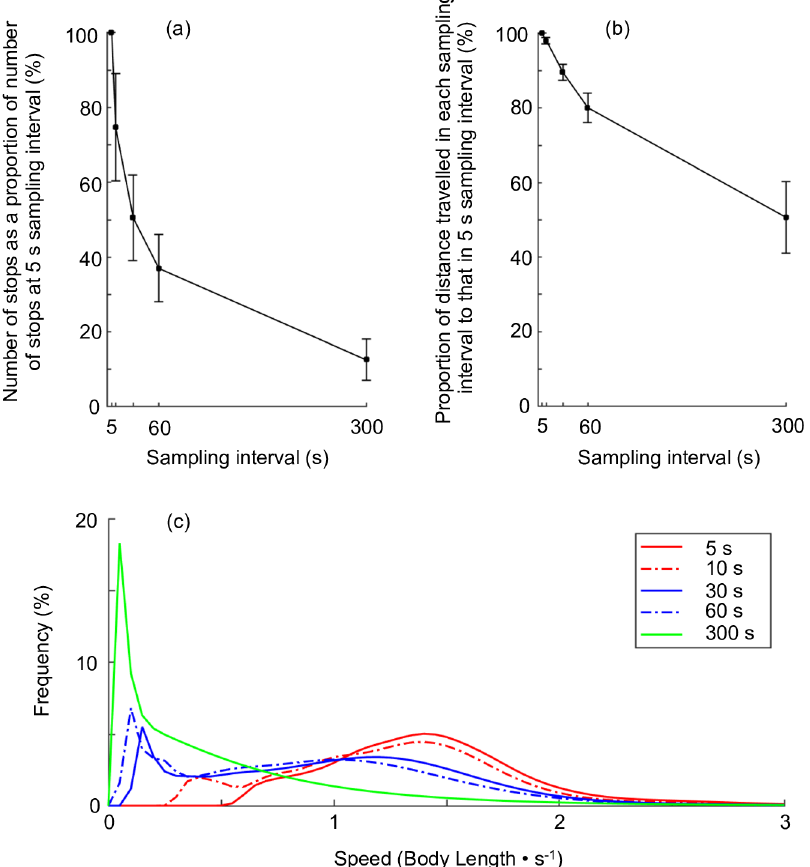
Fig 7. Comparison of stop numbers, distance travelled, and speed of tagged Siebold’s wrasse. (a) Number of ‘stop’ phases and (b) distance travelled as a proportion of that at 5 s sampling intervals for the seven tagged Siebold’s wrasse in five resampling interval lengths (5, 10, 30, 60 and 300 s). The error bar indicates the standard mean error. (c) Kernel density estimation of movement speed only during ‘move’ phase in the five resampling interval lengths. The speed was standardised (divided by the total length of each